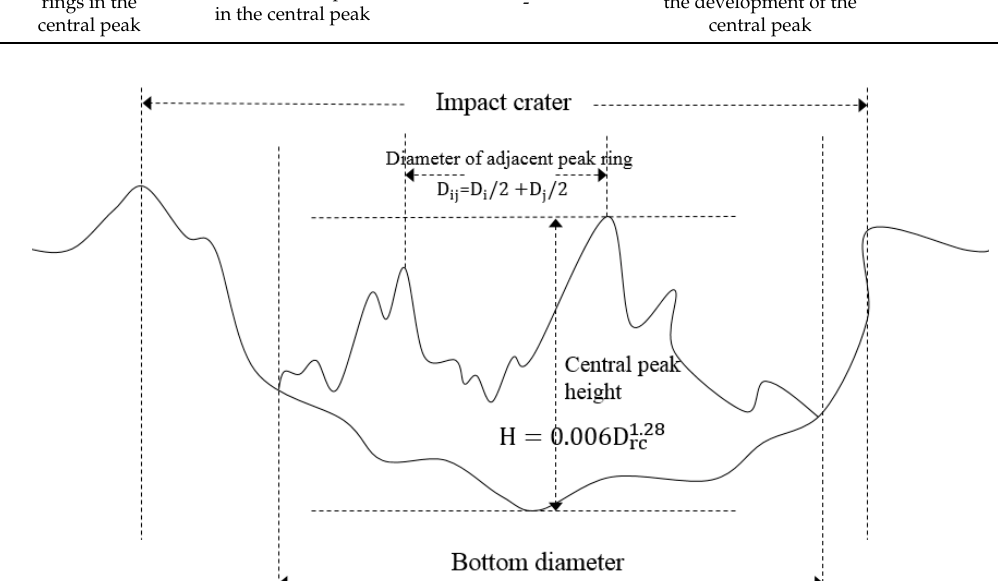
Figure 11. Schematic description of some of the indices in Table 5.